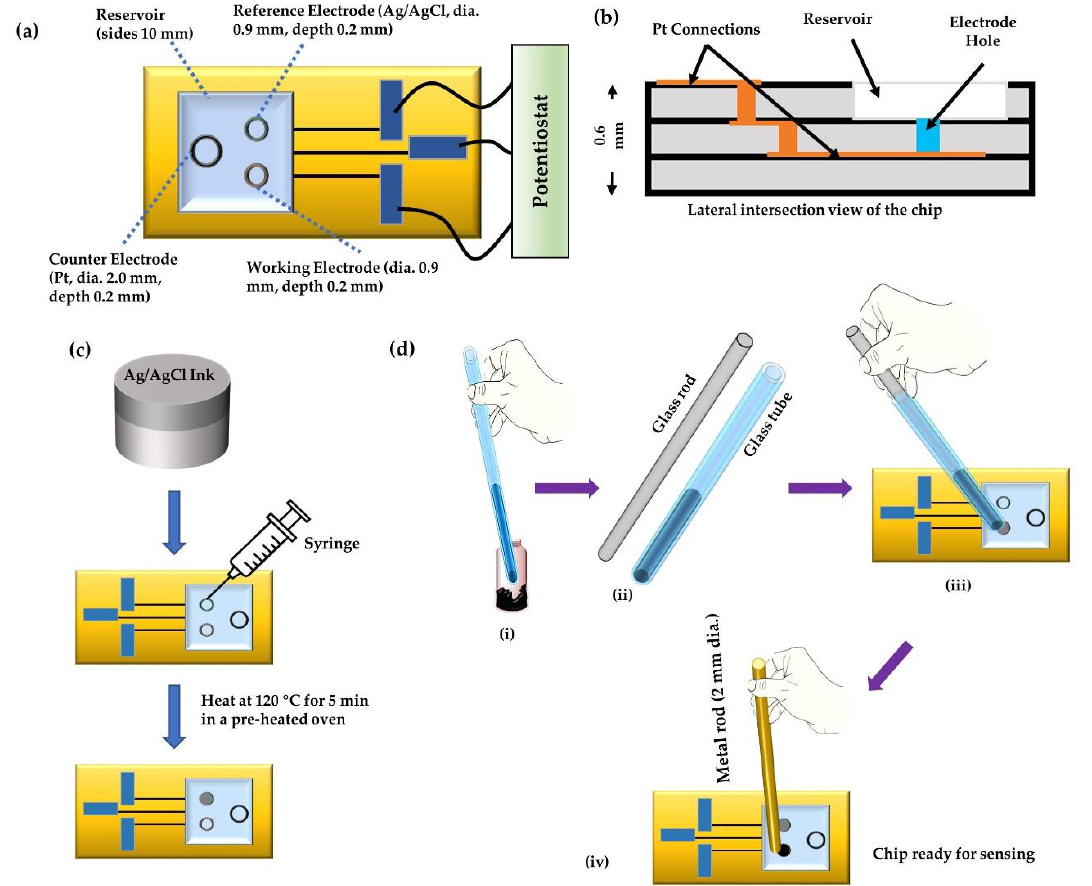
Figure 2. ( a ) Design of the chip along with its dimensions, ( b ) lateral inside view of the chip, ( c )–( d ) illustration of the method of filing the reference electrode and the working electrode.